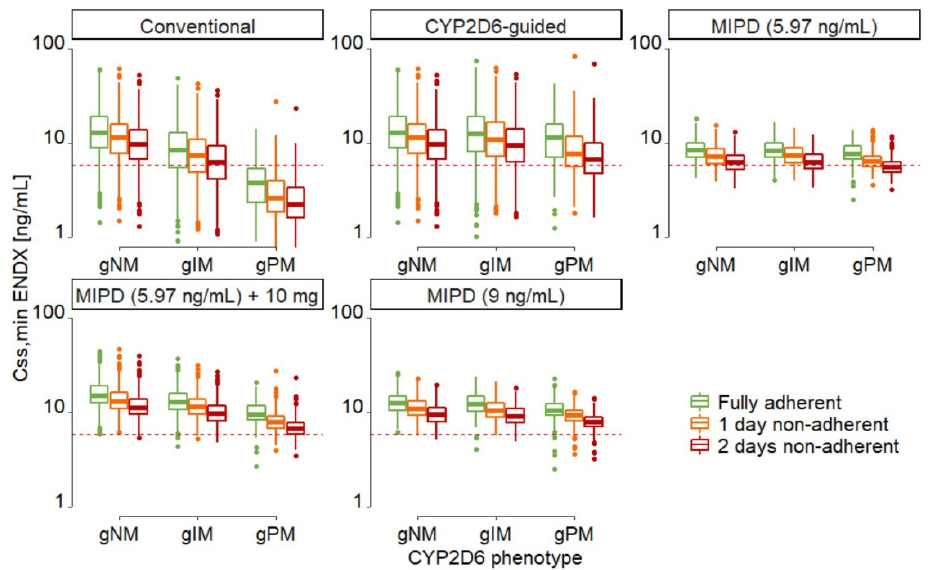
Figure 2. Minimum endoxifen concentrations at steady-state (C SS,min ENDX ) for different CYP2D6 genotype-predicted phenotypes in the five dosing strategies in strictly adherent patients (green), patients missing one dose per week (orange) and patients missing two consecutive doses per week (red) for six months, see Figure 1. Red dashed horizontal line: proposed endoxifen therapeutic threshold concentration (5.97 ng/mL) [7]; boxes: interquartile line (IQR) including median; whiskers: range from hinge to lowest/highest value within 1.5 IQR; points: data outside whiskers. Abbreviations: gNM, gIM, and gPM: genotype-predicted normal, intermediate, and poor metabolisers, respectively. Table 1. Percentage of strictly adherent patients at risk (%) for target non-attainment. CYP2D6 -Guided Patient Subpopulation Conventional Dosing